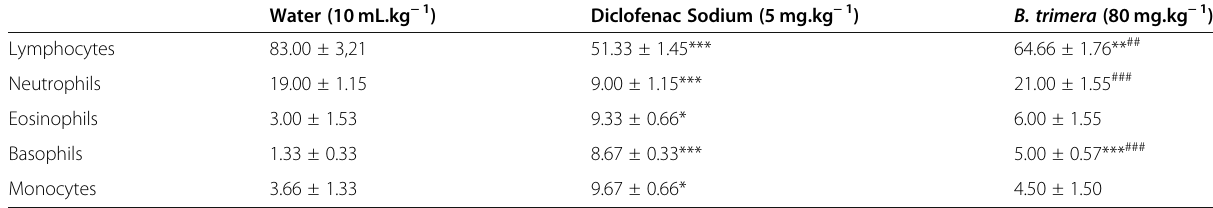
Table 1 Leukocyte count (%) in the blood of the different treated groups after the FCA injection (i.pl.) and the described